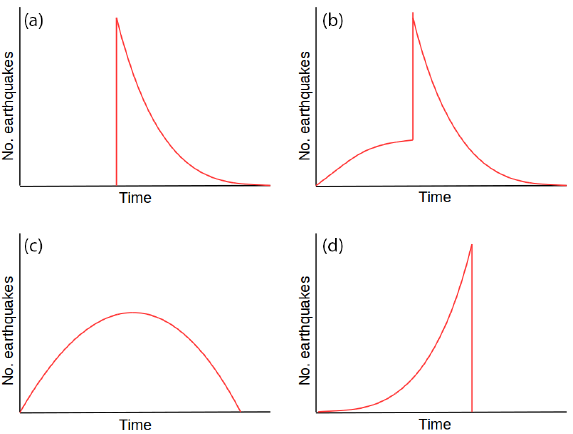
Figure 5. Seismic swarms are usually classified in three family types (A – panel a , B – panel b , C – panel c , Farrell et al., 2009; Brumbaugh et al., 2014). From our results at El Hierro in 2011– 2015, we propose a fourth family type D (panel d ), characterized by an increasing number of VT earthquakes and their magnitudes with time, and by a quick decay of the seismicity, in a matter of hours after a mainshock usually exceeding